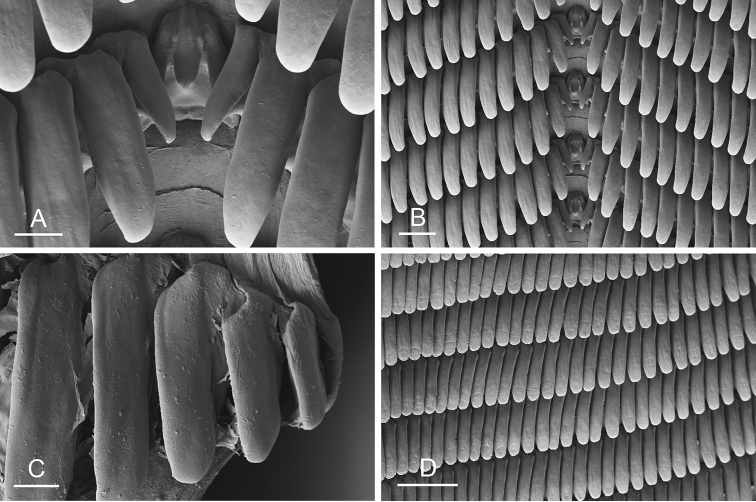
Radula, Peronia
peronii, Mauritius [5872] (MNHN-IM-2019-1605) A rachidian and innermost lateral teeth B rachidian and lateral teeth C outermost lateral teeth D lateral teeth. Scale bars: 40 μm (A), 100 μm (B), 20 μm (C), 200 μm (D).